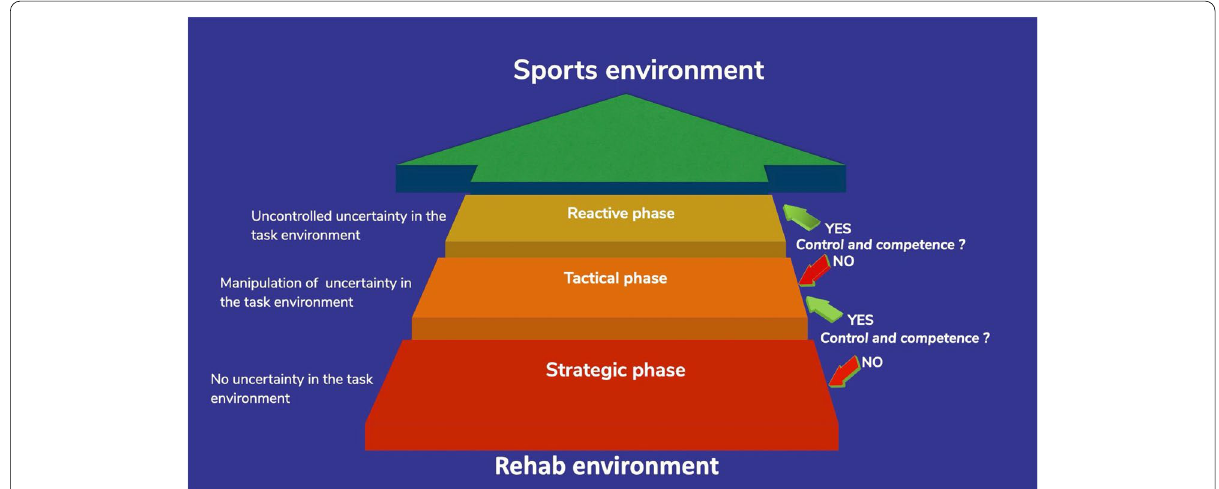
Fig. 2 A model outlining the staged progression from controlled environments to uncontrolled uncertainty. Advancing is based on demonstration of control and movement competence